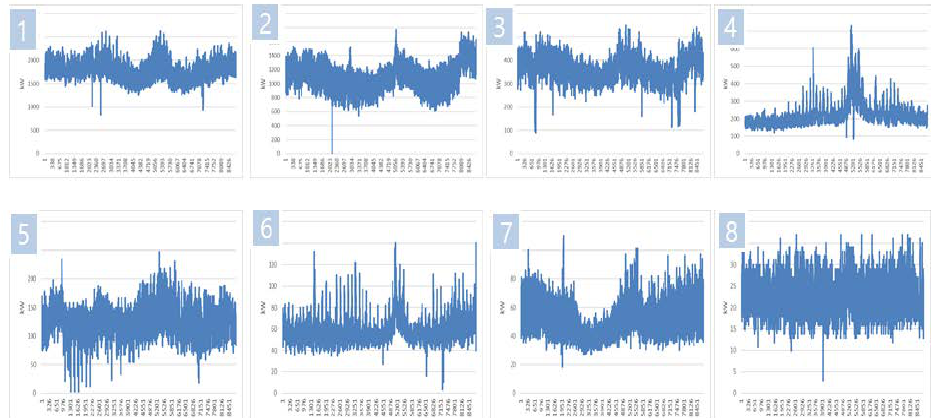
Figure 1. Annual hourly load patterns for eight islands.